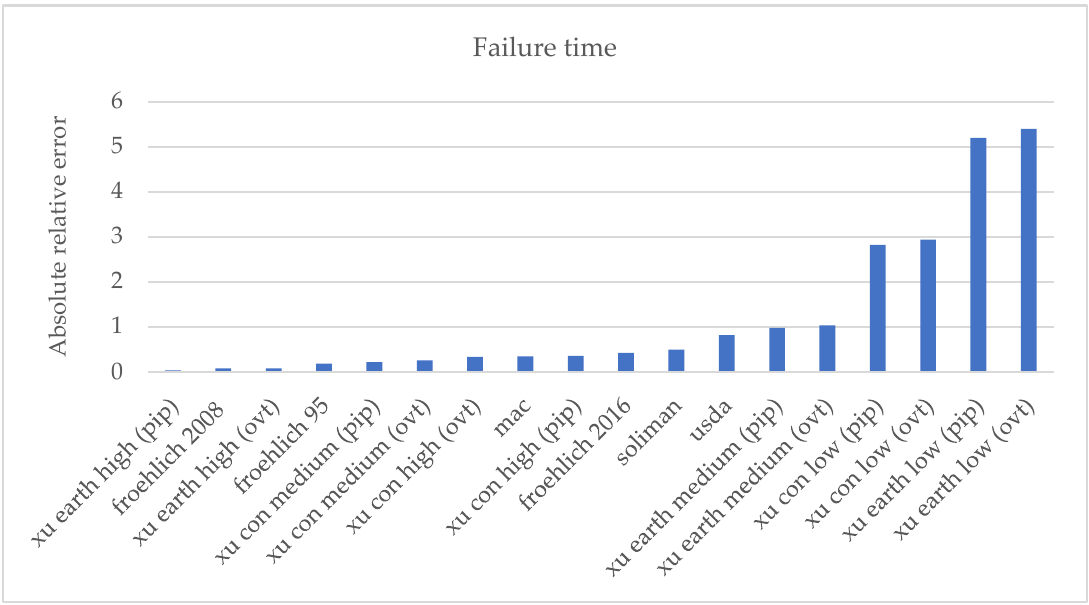
Figure 12. The absolute relative errors for the empirical formulas calculated for the failure time.